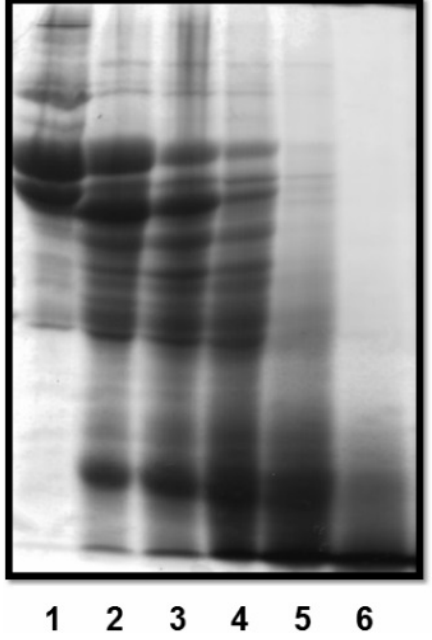
Figure 4. Dose-dependent hydrolysis of plasma clot by fraction F1.0 of C. urens . Washed plasma clot was incubated with various concentrations of fraction F1.0 in 0.05 M Tris-HCl, 0.15 M NaCl, pH 7.5 for 1 h at 37 °C. Lane 1: control (plasma clot alone); Lane 2: plasma clot + 0.09 µg/µL; Lane 3: plasma clot + 0.18 µg/µL; Lane 4: plasma clot + 0.37 µg/µL; Lane 5: plasma clot + 0.75 µg/µL; Lane 6: plasma clot + 1.5 µg/µL of fraction F1.0. The gel was stained with Coomassie brilliant blue